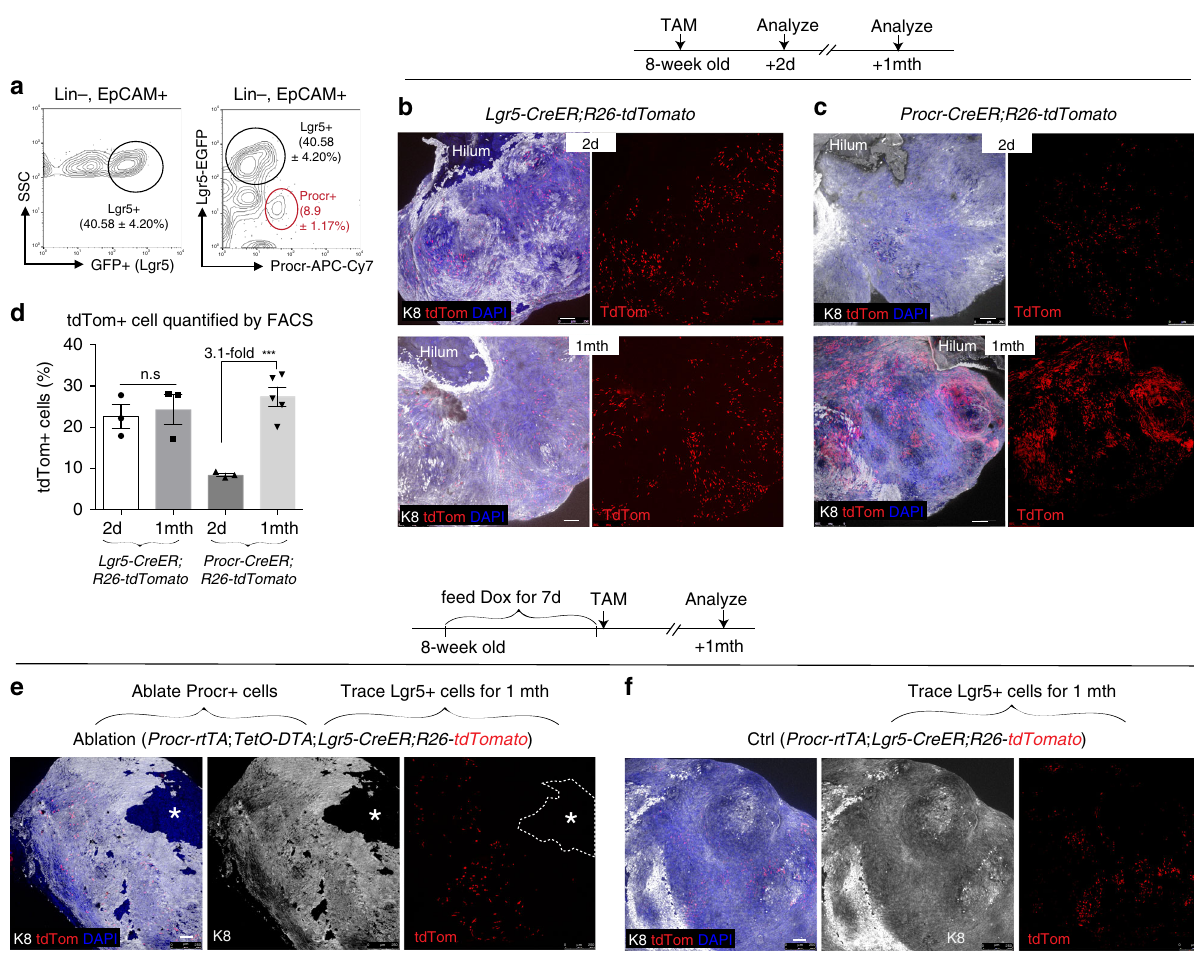
Fig. 6 Procr + cell exhibit distinct lineage tracing behaviors compared with Lgr5 + cells. a FACS analysis of 8-week-old Lgr5-CreER-IRES-EGFP mice ovary showing that the OSE cells, consisting of 40.58± 4.20% GFP + (Lgr5 + ) cells, and Lgr5 + and Procr + cells are two distinct OSE cell populations. n = 3 mice. b , c Lgr5 + cells ( b ) and Procr + cells ( c ) were traced for 2d and 1 month using (8-week-old) Lgr5-CreER;R26-tdtomato mice ( b ) and Procr-CreER;R26- tdtomato mice ( c ). Ovary whole-mount confocal images showing the distribution pattern of labeled (tdTom + ) cells in the OSE (K8 + ). Scale bar, 100 μ m. n = 3 mice and six ovaries in each time point. d FACS quanti fi cation of tdTomato + OSE cells (Lin − , EpCAM + , tdTomato + ) after 2d and 1mth tracing, in Lgr5-traced and Procr-traced mouse models. Data are displayed as mean±s.e.m. Unpaired two-tailed t test is used for comparison. *** P < 0.001. n.s, not signi fi cant. n = at least three mice in each time point. e – f Strategy of ablating Procr + cells and tracing Lgr5 + cells using Procr-rtTA;TetO-DTA;Lgr5-CreER; R26-tdtomato mice. Dox was fed into 8-week-old adult mice to ablate Procr + cells, and 7 days pi, TAM was administered to initiate tracing of Lgr5 + cells. In the ablation group, ovary whole-mount confocal images showing loss of OSE (absence of K8 staining, star). Lgr5 + cell-derived progeny (tdTom + cells) displayed dispersed pattern, suggesting the loss of OSE injury did not stimulate more robust Lgr5 + cell division ( e ). In control group ( Procr-rtTA;Lgr5-CreER; R26-tdtomato ), ovary whole-mount confocal images with K8 staining indicating the Lgr5 + cell-derived progeny cell pattern in normal homeostasis ( f ). Scale bar, 100 μ m. n = 3 mice and six